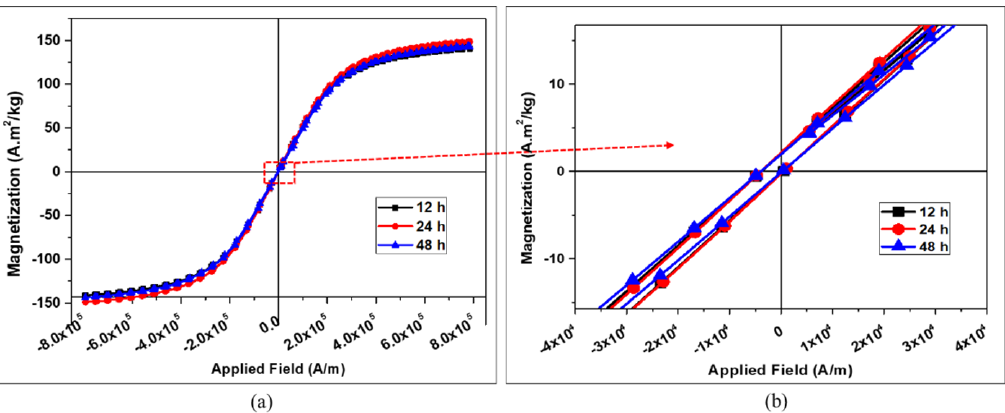
Figure 10. Hysteresis loops of 80nFe-19Al-1MWCNT according to the milling time: ( a ) full loops and ( b ) magnification of the selected region. Table 3. Magnetic properties and density of 80nFe-19Al-1MWCNT according to the milling time.